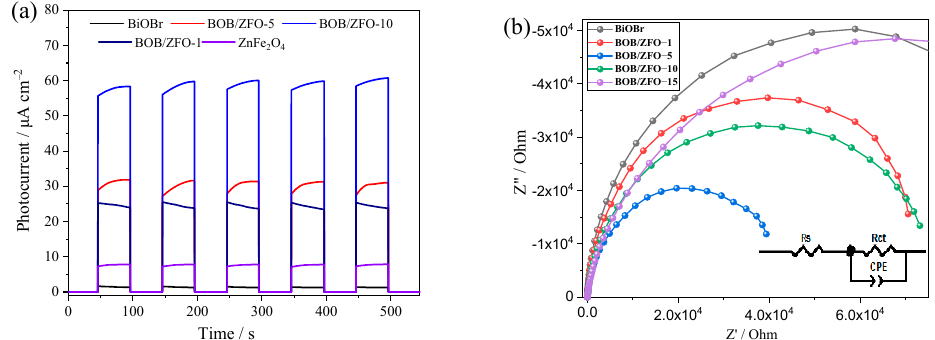
Figure 8. ( a ) The transient photocurrent response plots and ( b ) the electrochemical impedance (EIS) for BiOBr, ZnFe 2 O 4 and BOB/ZFO-x spectra (EIS) for BiOBr, ZnFe 2 O 4 and BOB/ZFO-x nanocomposites.